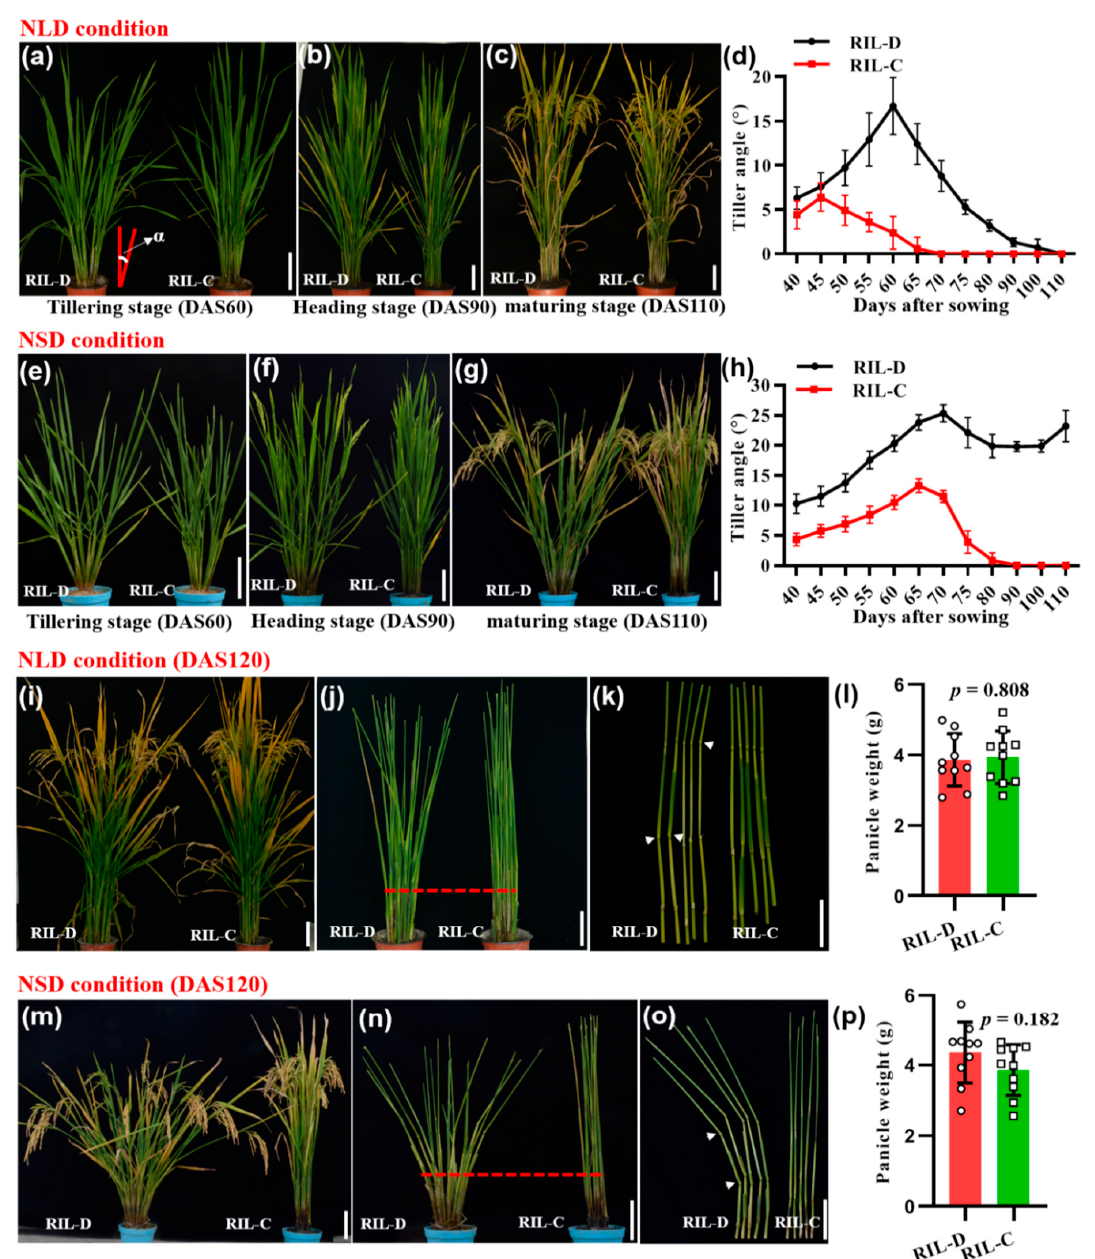
Figure 1. Phenotypic analysis of RIL-D and RIL-C from DAS40 to DAS110 under natural long-day (NLD) and short-day (NSD) conditions. ( a – c ) RIL-D and RIL-C plants under NLD conditions at the tillering stage ( a ), heading stage ( b ), and maturing stage ( c ). ( d ) The dynamic tiller angle of RIL-D and RIL-C under NLD conditions. ( e – g ) RIL-D and RIL-C plants under NSD conditions at the tillering stage ( e ), heading stage ( f ), and maturing stage ( g ). ( h ) The dynamic tiller angle of RIL-D and RIL-C under NSD conditions. ( i ) RIL-D and RIL-C plants under NLD conditions. ( j , k ) Stems of RIL-D and RIL-C under NLD conditions. ( l ) Comparison of the panicle weight between RIL-D and RIL-C under NLD conditions. ( m ) RIL-D and RIL-C plants under NSD conditions. ( n,o ) Stems of RIL-D and RIL-C under NSD conditions. ( p ) Comparison of the panicle weight between RIL-D and RIL-C under NSD conditions. The upper and lower parts of red dotted lines indicate curved stems and tiller angle, respectively, and white arrows indicate the curved site (node) of the stem. All data shown represent mean ± SD (standard deviation; n = 10). Two-tail Student’s t -tests were used for statistical analysis. Bar = 10 cm.